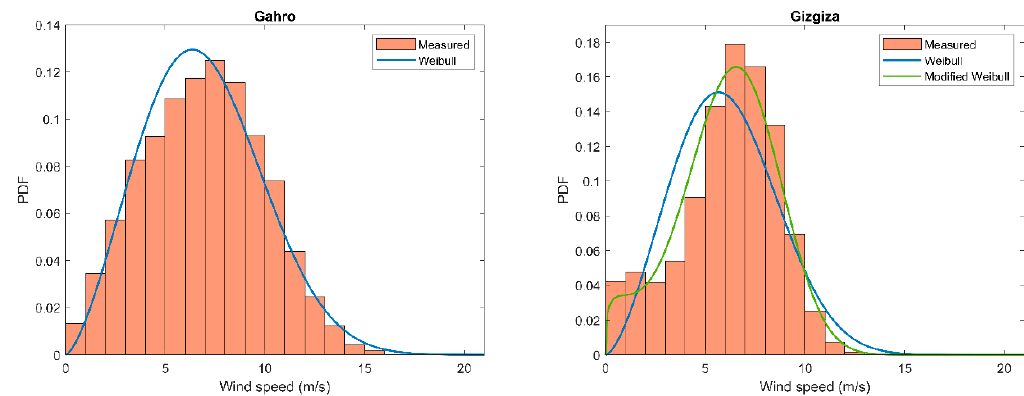
Figure 8. Distribution of the wind speeds for Gahro and Gizgiza for the year 2000. The distribution based on the fitted Weibull parameters are also indicated. For Gizgiza an additional modified Weibull fit is indicated, where high and low wind speed periods are singled out and fitted separately.